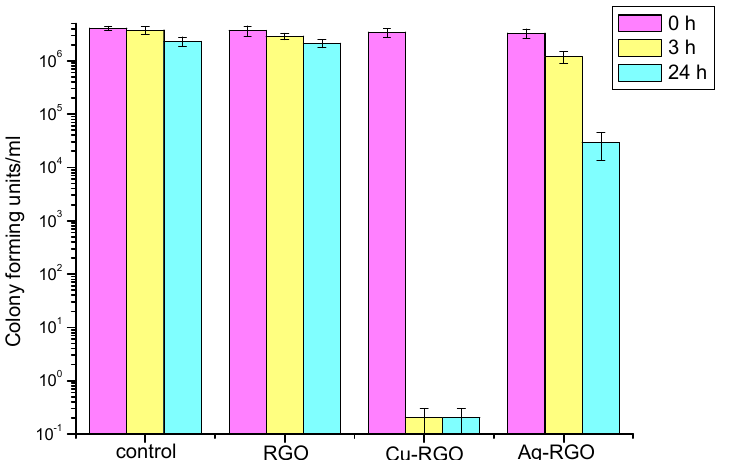
Figure 8. Survival of Staphylococcus aureus bacteria after 0, 3 and 24 h treatment with RGO and metal–RGO composites.